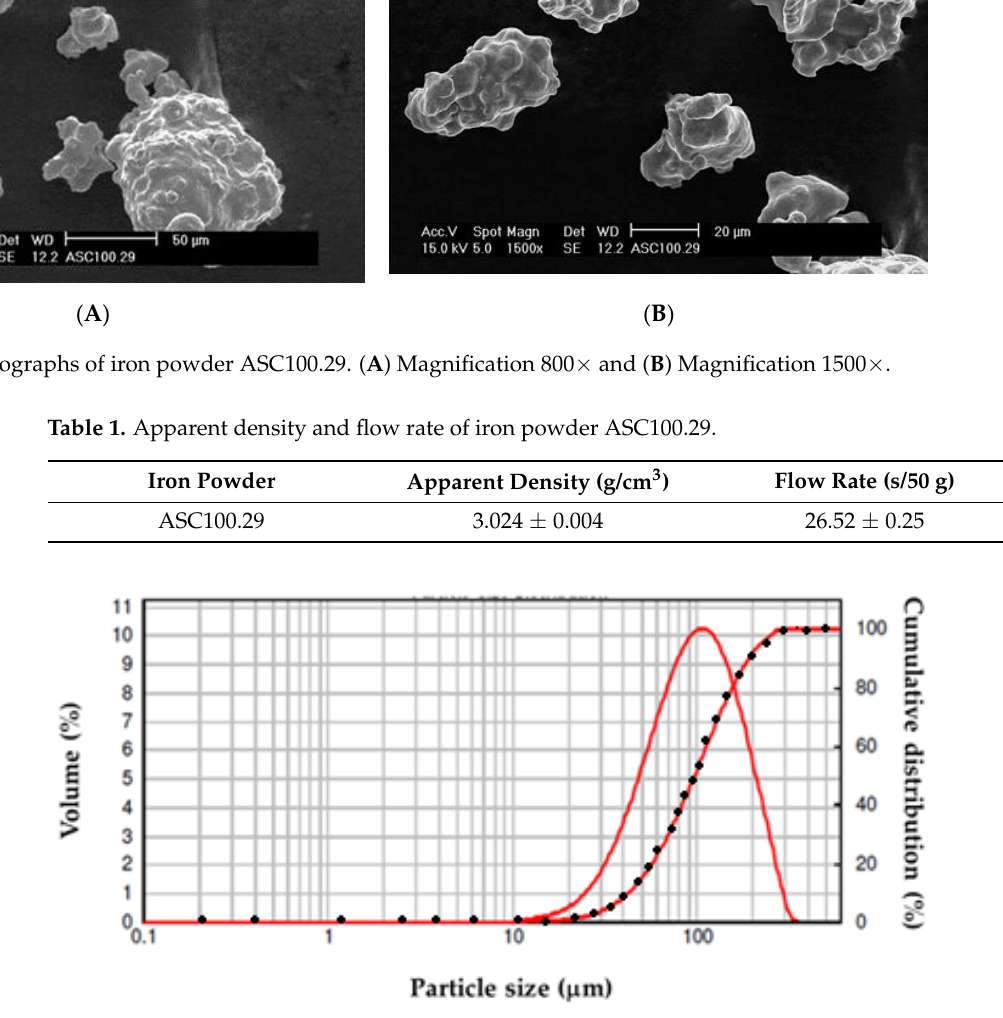
Figure 4. Particle size distribution of ASC100.29 iron powder (red line corresponds to volume (%), and the dotted line is cumulative distribution (%)).